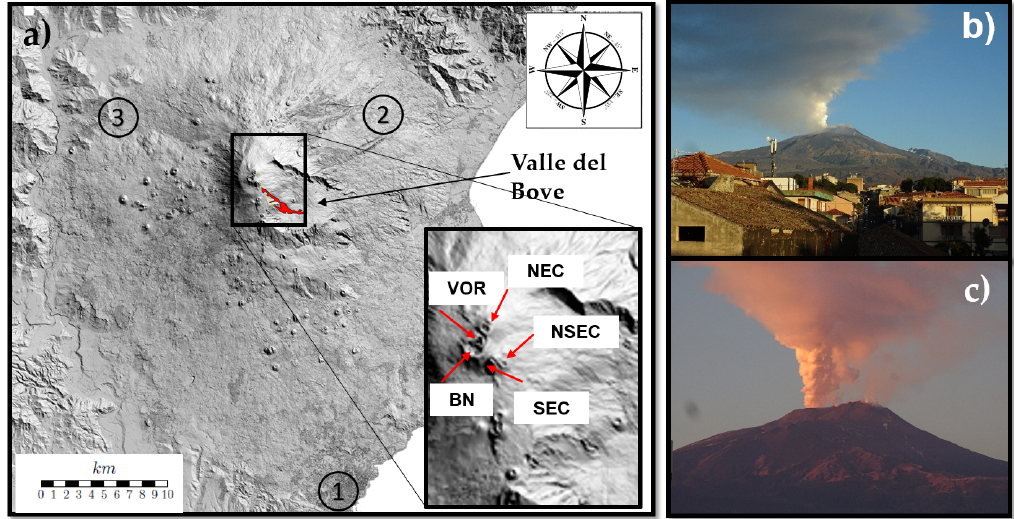
Figure 1. ( a ) Map of Etna volcano with the circles indicating the location of (1) Lidar station, (2) the sunphotometer, (3) the visible calibrated camera; photos of the volcanic plume taken by B. Behncke from a small town on the Etna’s south flank on 28 December 2018 ( b ) in the morning and ( c ) in the